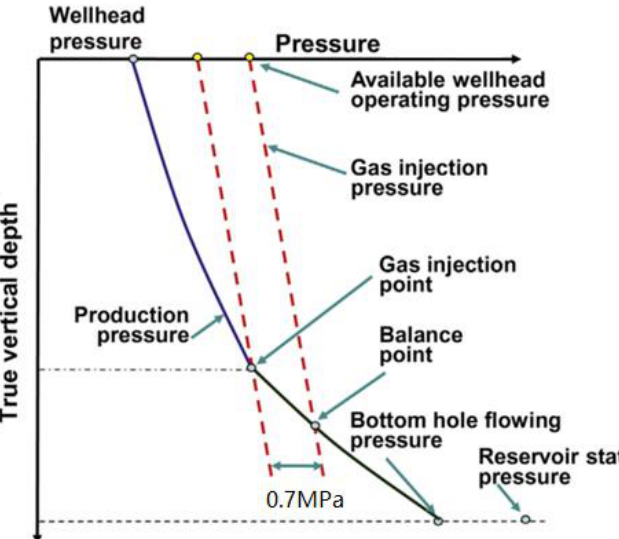
Figure 8. Depth of the operating gas injection point. With variable sensitive data of GLR, the lifting liquid rate can be obtained at a different pressure gradient curve (Figure 9).